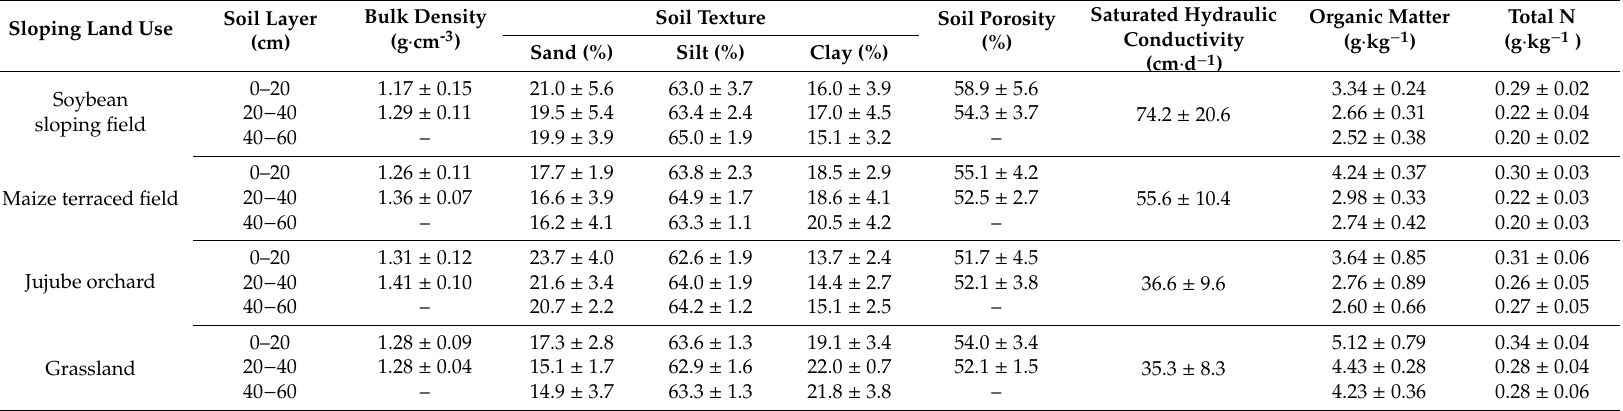
Table 2. Physical properties and nutrient content of experimental land uses. The sampling date was September 5, 2014. Date are mean ± SD, n = 3. Soil